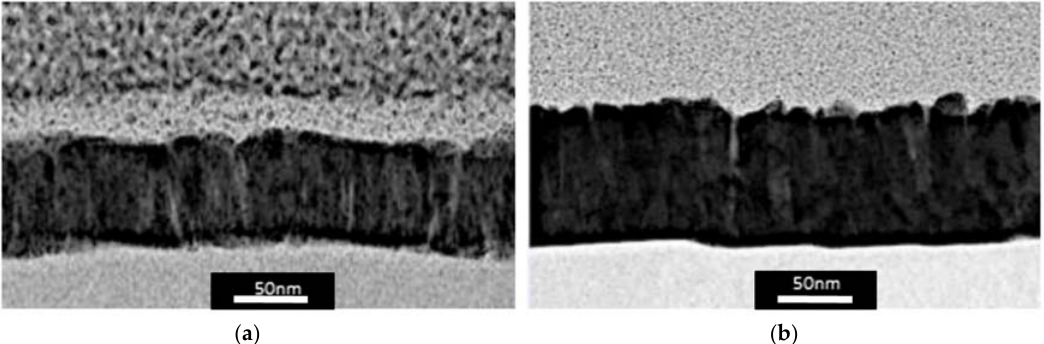
Figure 3. STEM image of the samples produced by Pt ‐ C and Pt targets sputtering using pulsed magnetron sputtering regime (frequency 10 kHz). ( a ) Pt ‐ C film deposited on Ti substrate. ( b ) Pt film deposited on Ti substrate. Scale bar 50 nm.